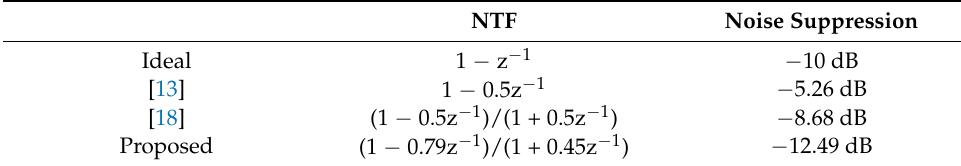
Table 1. List of noise transfer function.